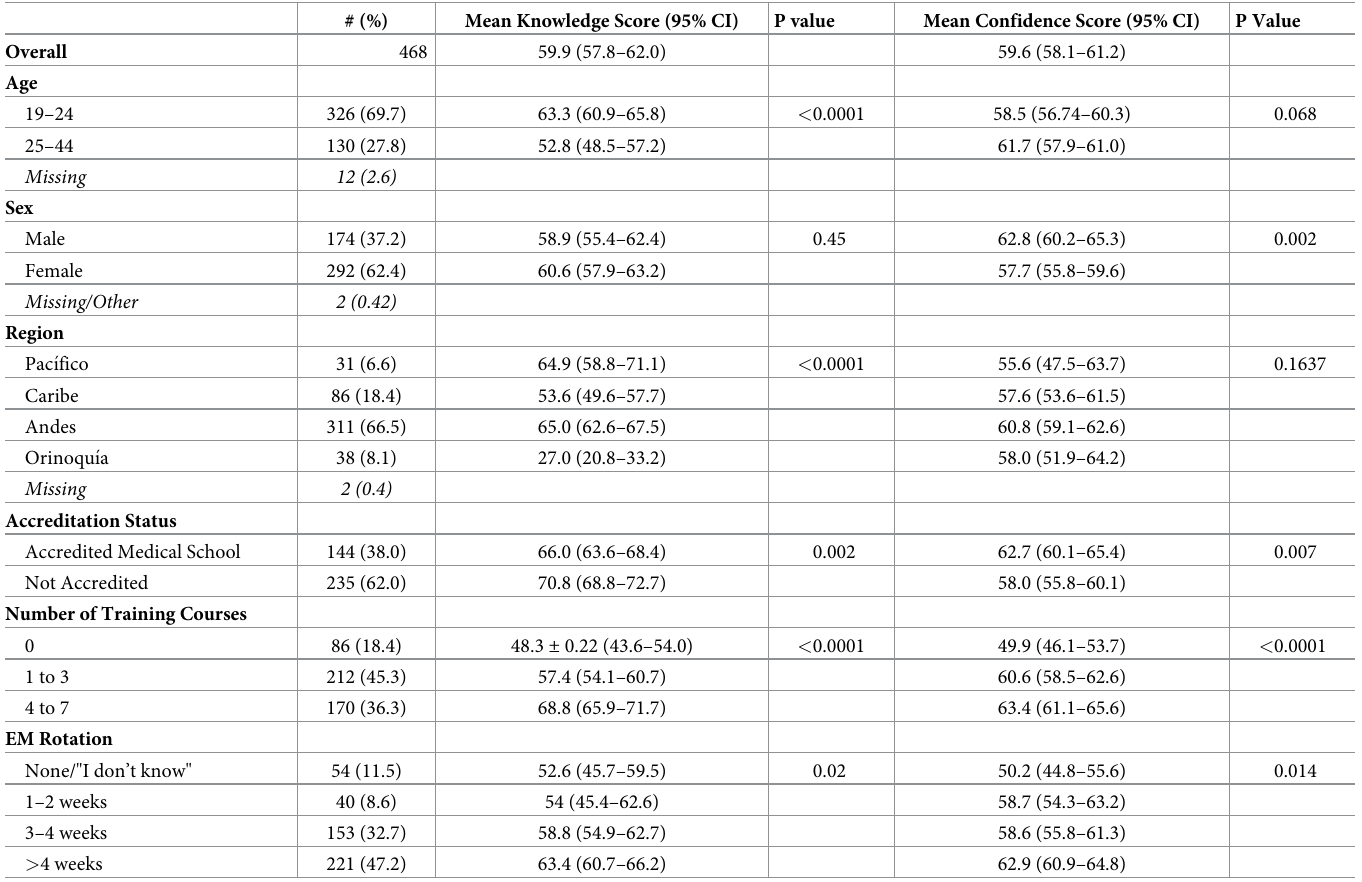
Table 2. Baseline characteristics, knowledge scores and confidence scores in emergency care among 4 th year medical students in Colombia compared with one-way